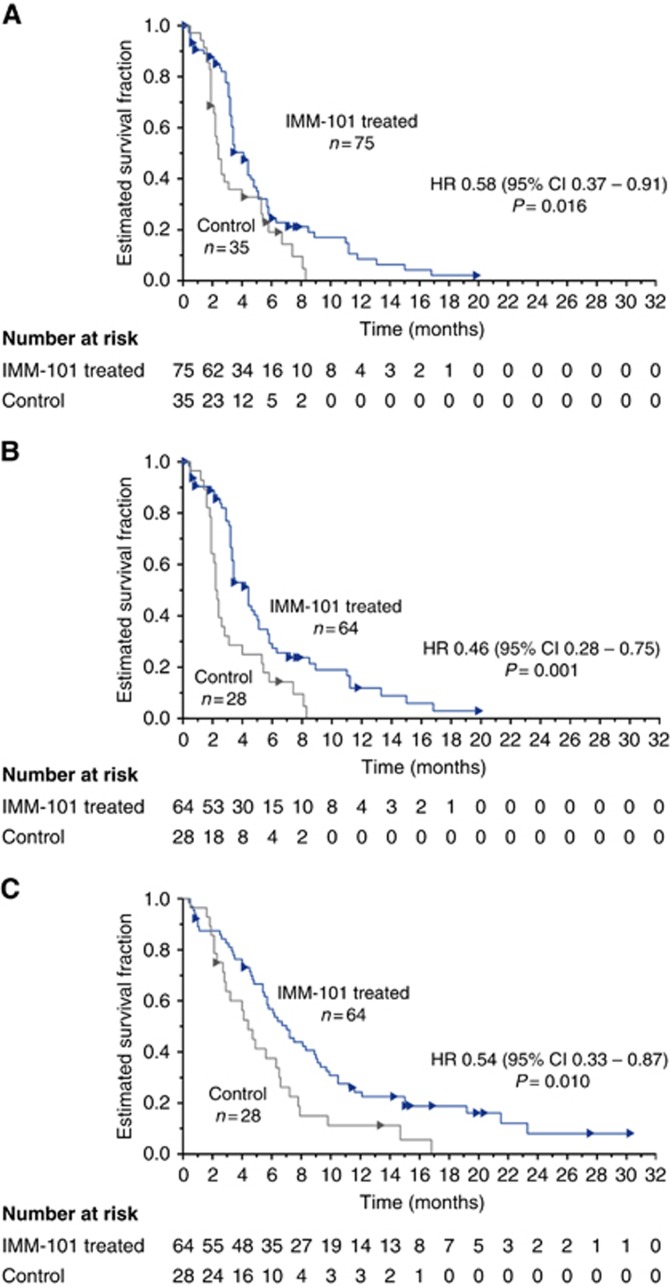
Progression-free survival ITT Analysis Set (A) and ITT Metastatic Subgroup (B). Overall survival Metastatic Subgroup (C). Arrows denote censored events. IMM-101 treated: IMM-101+GEM; Control: GEM alone.